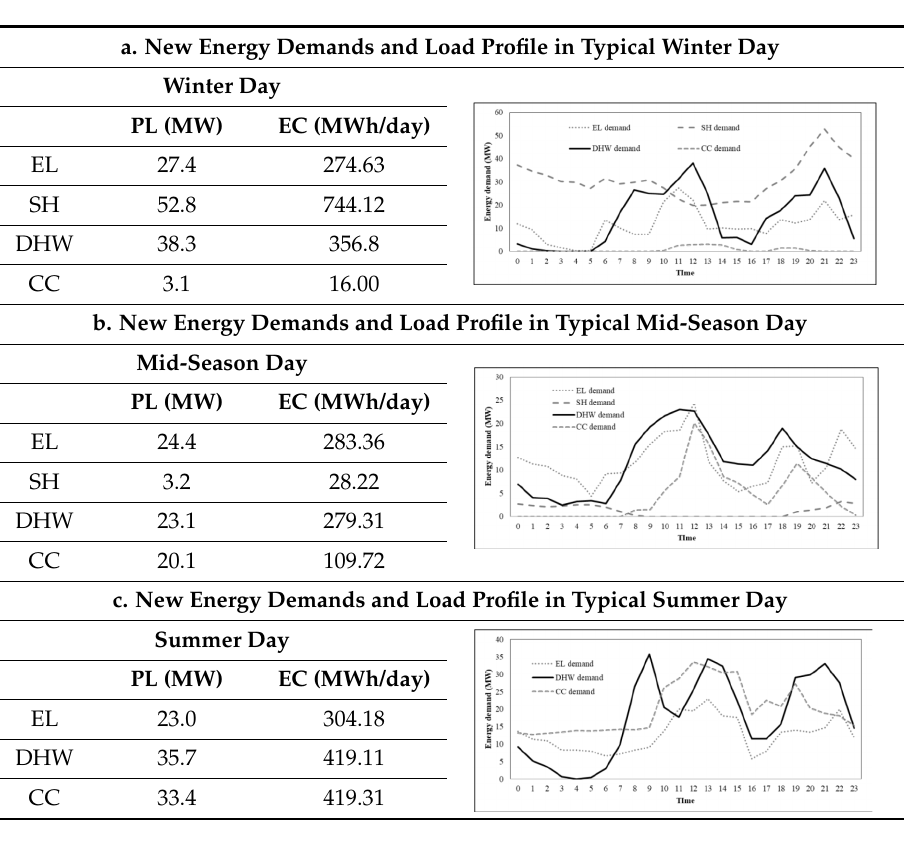
Table 3. New energy demands and load profiles for Xizhou town after energy demand